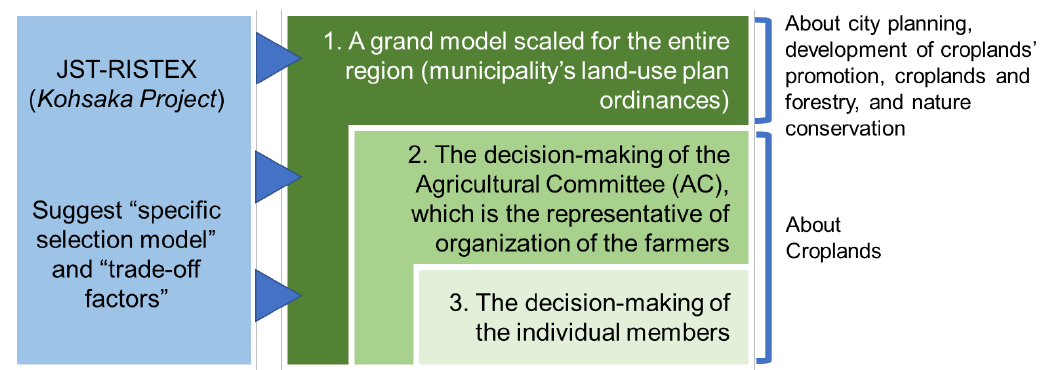
Figure 7. Multi-layered decision-making of community members about croplands.